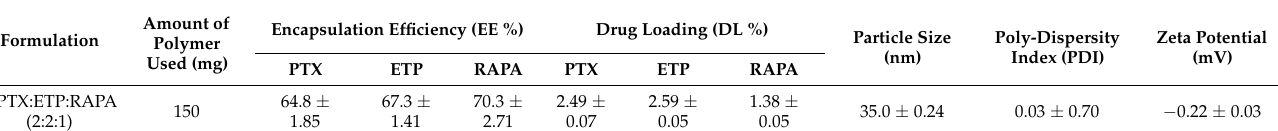
Table 2. Physicochemical characterization of paclitaxel (PTX), etoposide (ETP), and rapamycin (RAPA)-loaded mPEG-pH-PCL micelles (n = 3).